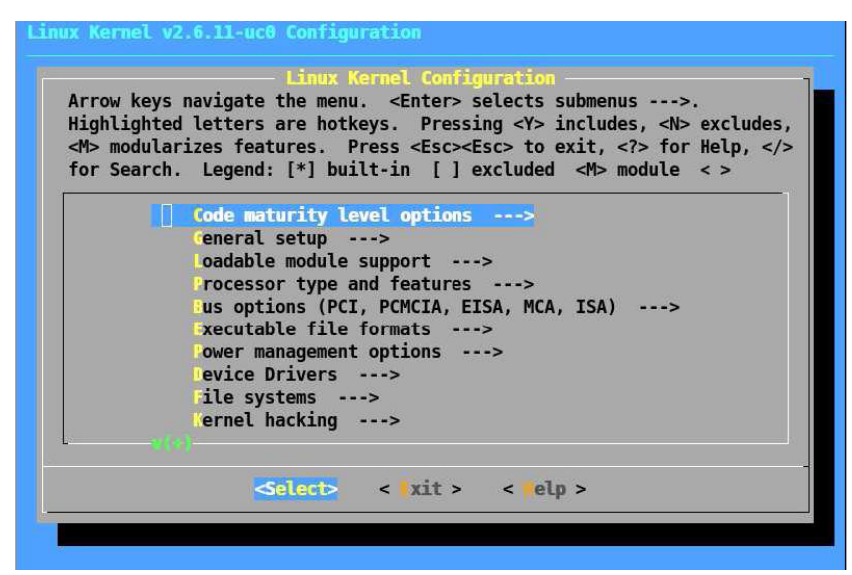
Figure 6. Kernel configuration menu.